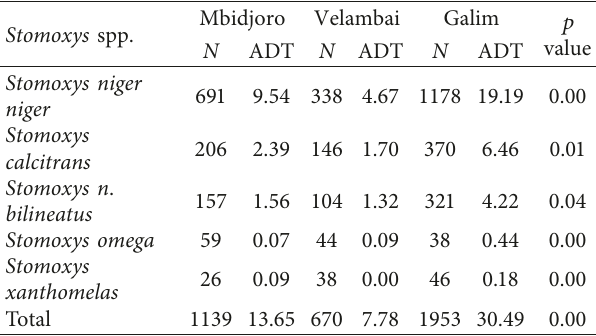
ADT: trap apparent